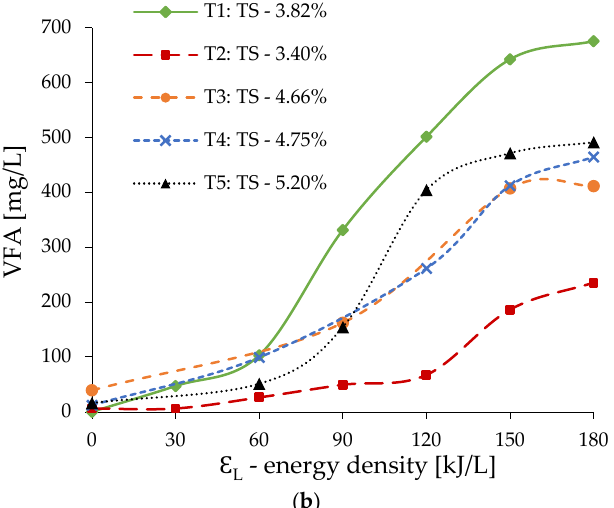
Figure 3. Effect of energy density on SCOD ( a ) and VFA ( b ) release from thickened waste activated sludge.